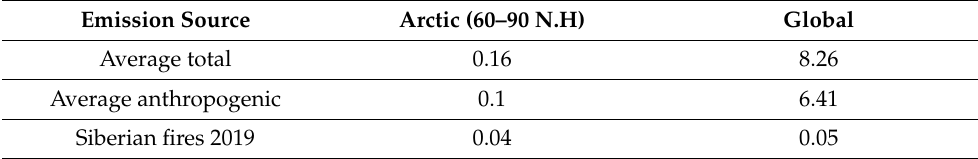
Table 1. Annual emission of BC, Tg.